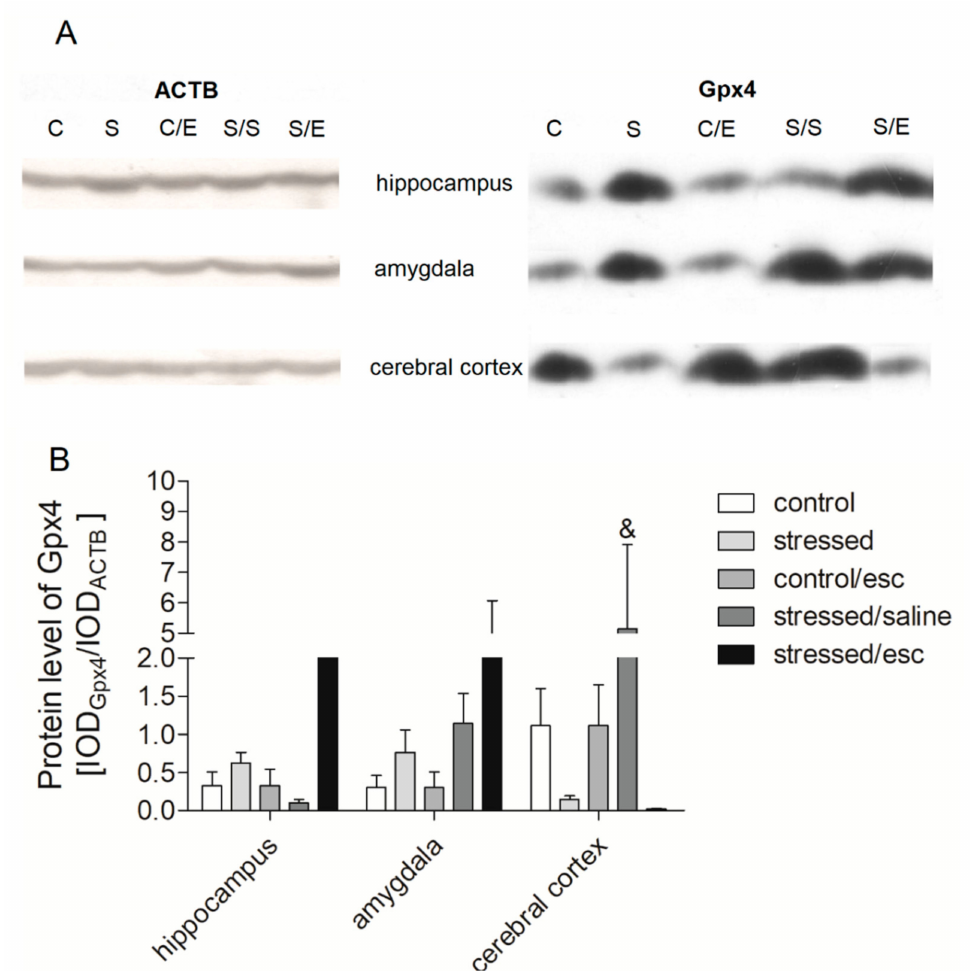
Figure 4. Protein expression of Gpx4 in brain structures of animals exposed to CMS for two weeks (control, stressed) and in animals exposed to CMS for seven weeks and administered vehicle (1 mL/kg) or escitalopram (10 mg/kg) for five weeks (control/esc, stressed/saline, stressed/esc). ( A ) Representative western blot analysis in midbrain and cerebral cortex. C–controls, S–stressed for two weeks, C/E–control/escitalopram, S/S–stressed/saline, S/E–stressed/escitalopram. ( B ) Levels of Gpx4 proteins measured in hippocampus, amygdala and cerebral cortex. Samples containing 25 µ g of proteins were resolved by SDS-PAGE. The intensity of bands corresponding to Gpx4 was analysed by densitometry. Integrated optical density (IOD) was normalized by protein content and a reference sample (see the Methods Section for details). The graphs show the mean IODs of the bands from all analysed samples. The IOD gene /IOD ACTB method was used to estimate the relative protein expression levels in the analysed samples. Data represent means ± SEM. n = 6. & p < 0.05 for the difference between stressed/saline and stressed/escitalopram